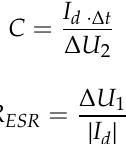
Figure 5. The applied way of determining values of capacitance C and resistance R ESR after noise measurements. 4. Test Results of Prototype Samples of Supercapacitors As part of the project, prototype samples of supercapacitors were subject to evaluation. They were made by technology based on aqueous electrolyte. The used samples of supercapacitors in measurements were presented in more detail in [35]. Subsequently, the manufactured supercapacitors were subject to forming and preliminary measurements in order to determine their electrical parameters: C and R ESR . As part of the aging test by carrying out charging/discharging processes, the measurements were performed at the adopted current density of 5 A/g (test current I d = 1225 mA) and the maximum 1.5 V charging voltage with C and R ESR measurements performed every 250 cycles at current density 1 A/g (245 mA). A total of over 120,000 cycles were performed within the entire measurement period of the tested sample labelled P1. Measurements of C and R ESR during the test are presented in Figure 6. Measurements applying the proposed noise method were also carried out for sample P1 when it was as-fabricated, after 48,000 cycles and after the completion of